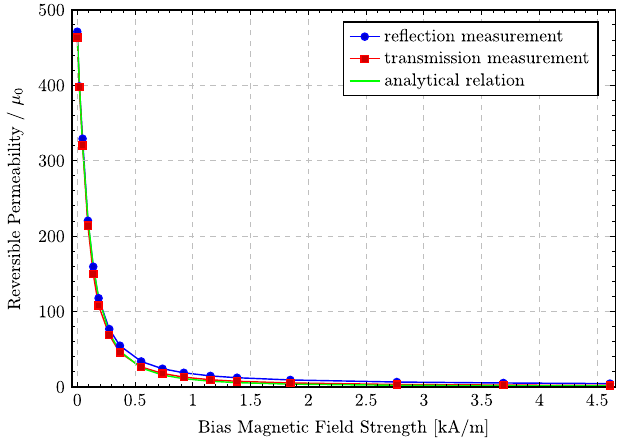
frequency.FIG. Qf product for the series representation as FIG. 10. The μ 0 s obtained from the reflection measurement analysis for different bias field strengths as a function of